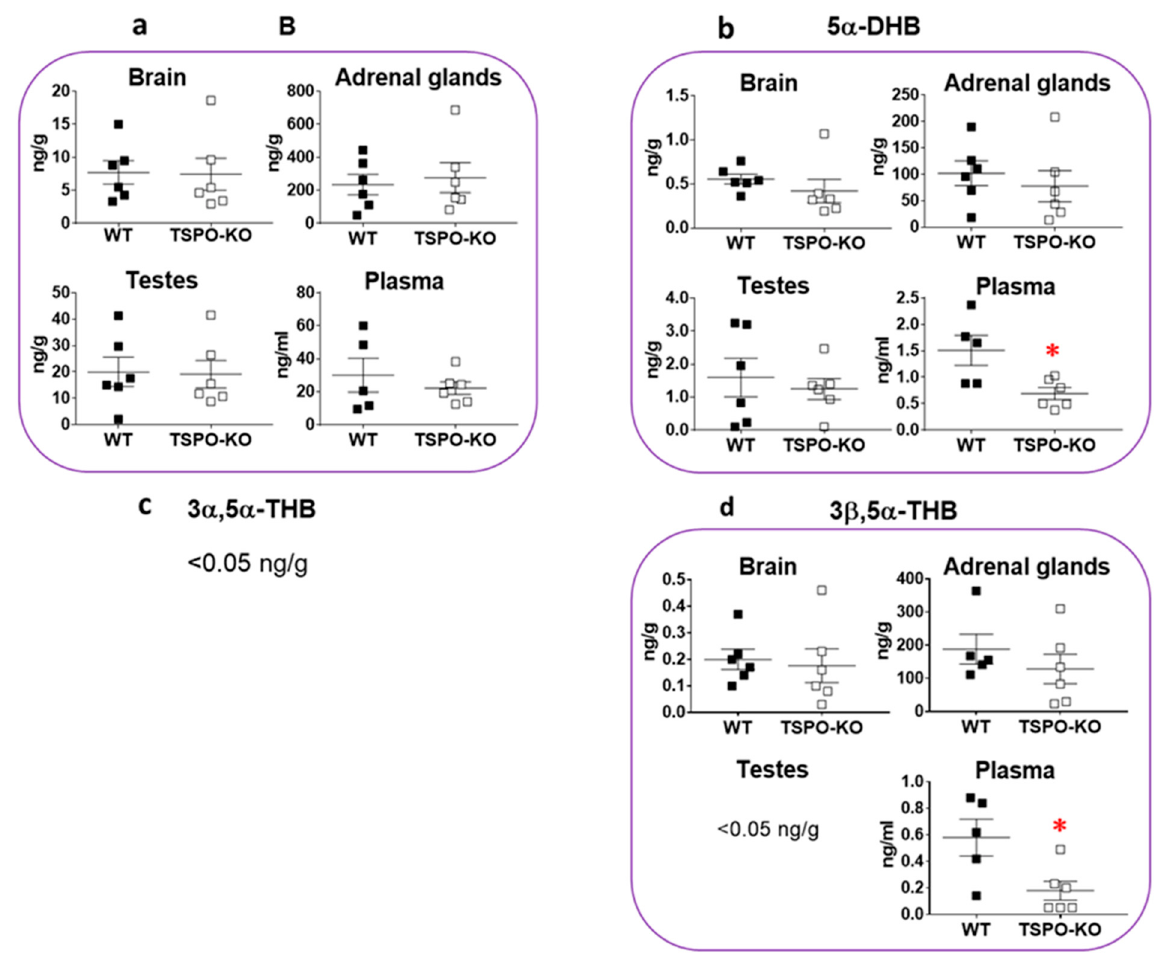
Figure 5. Concentrations of B and its 5 α -reduced metabolites in tissues of male WT and TSPO-KO mice analyzed by GC-MS/MS as described in the Material and Methods section. Data are expressed as means ± SEM and were analyzed by unpaired t -test. * p < 0.05.